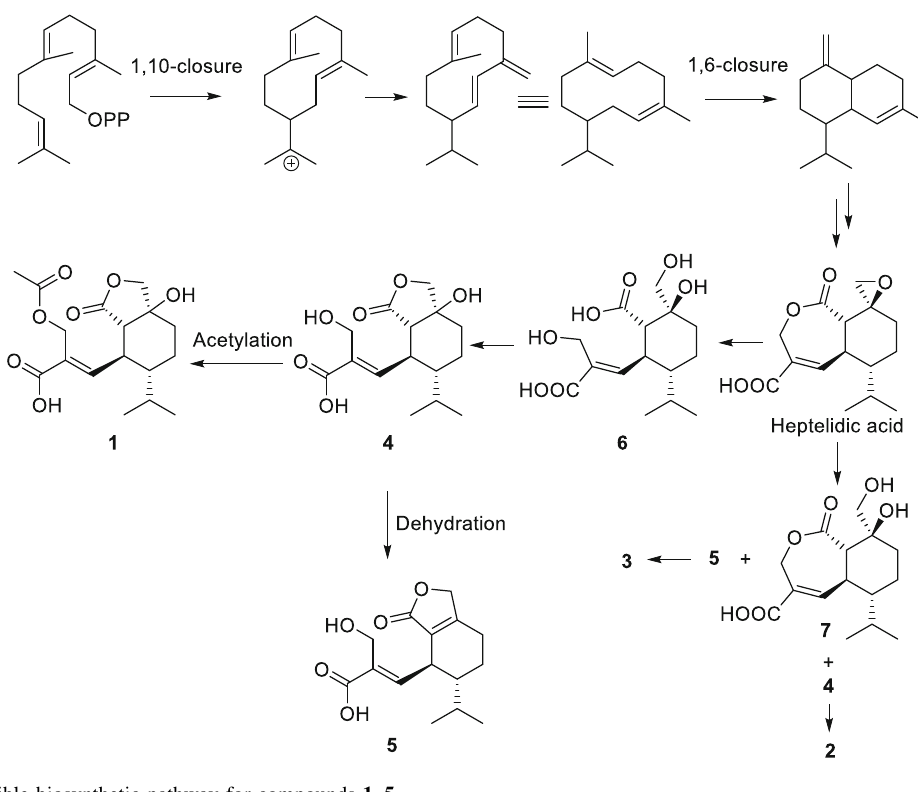
Fig. 5 The plausible biosynthetic pathway for compounds 1 –